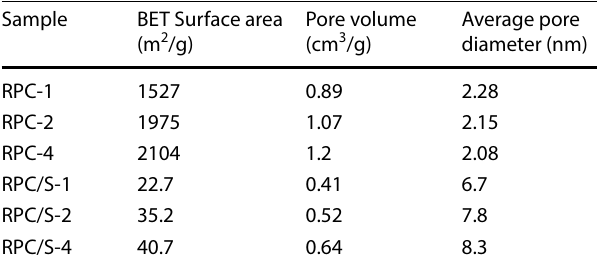
Table 1 Textural properties of rambutan peel derived porous car- bons and their corresponding composites with sulfur Sample